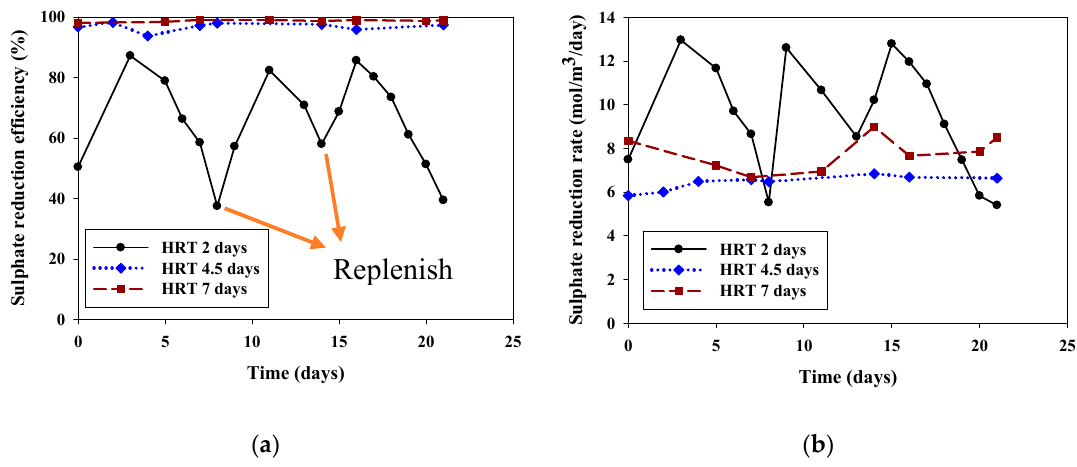
Figure 9. Effect of HRT over time at 30 °C and pH 5 for ( a ) sulphate reduction efficiency and ( b ) Figure 9. E ff ect of HRT over time at 30 ◦ C and pH 5 for ( a ) sulphate reduction e ffi ciency and ( b ) sulphate sulphate reduction rate. reduction